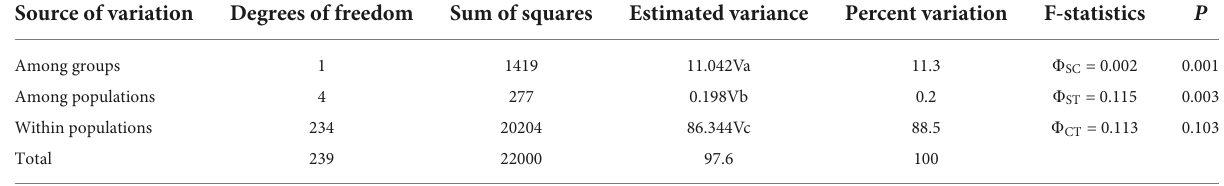
TABLE 3 Analysis of molecular variance and genetic differentiation index in nDNA microsatellite loci among wild populations and the laboratory strain. Source of variation Degrees of freedom Sum of squares Estimated variance Percent